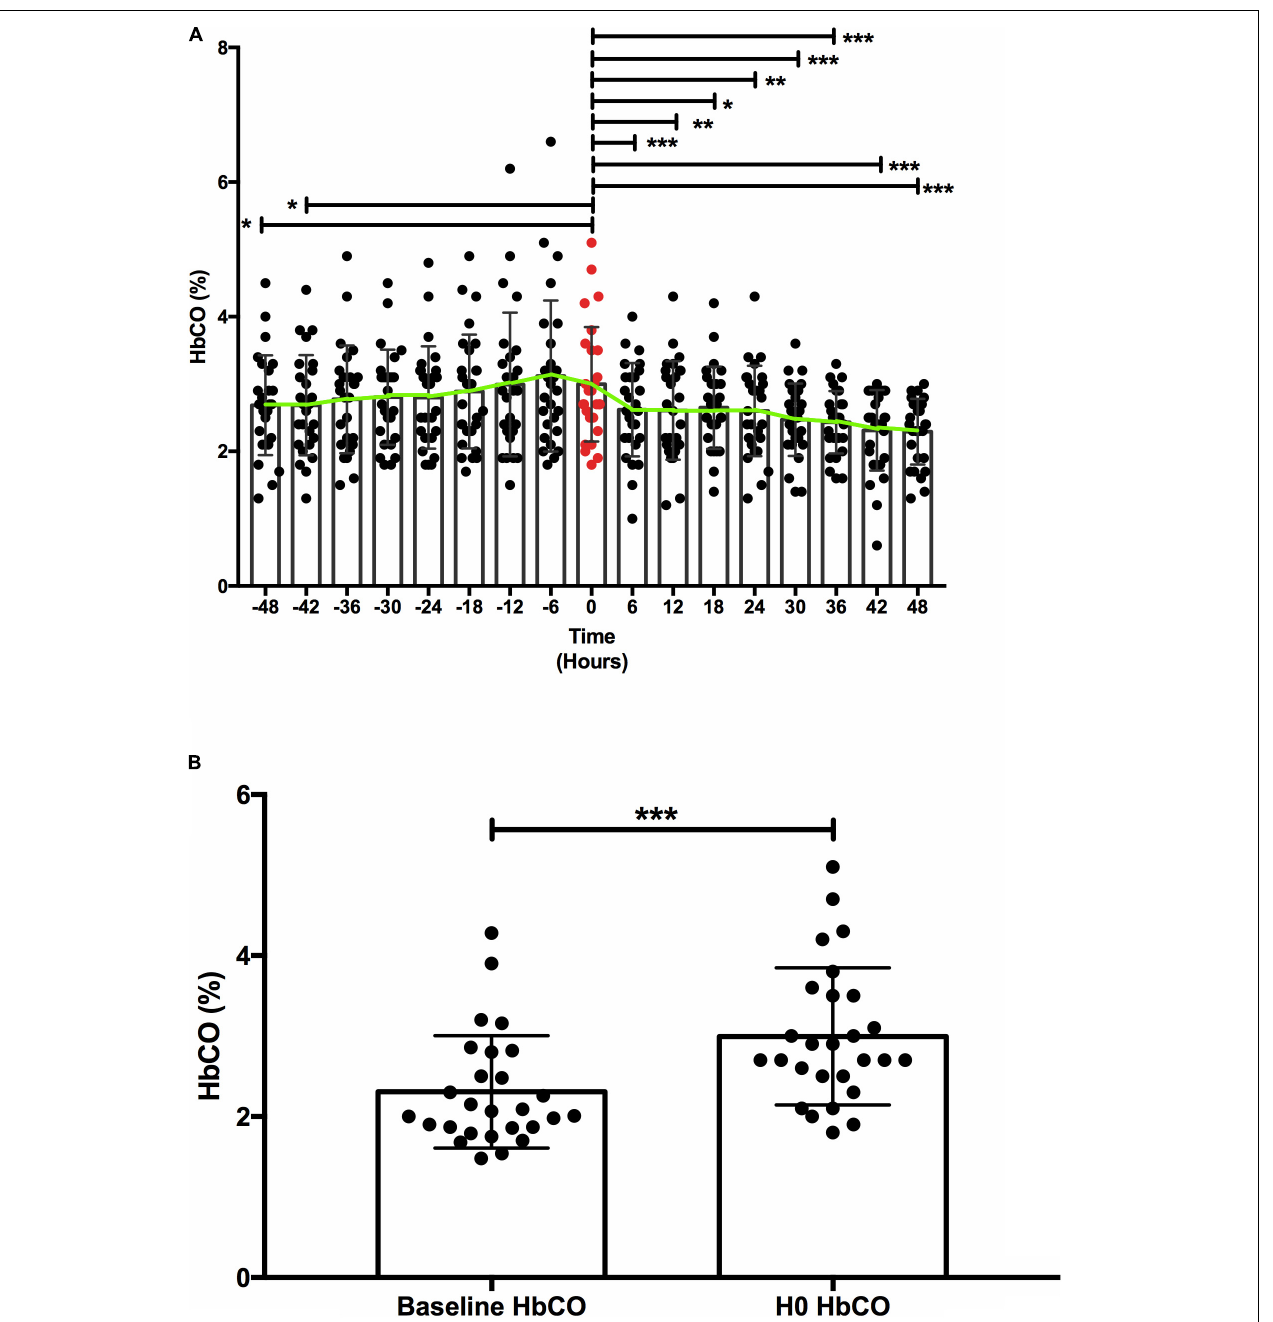
FIGURE 2 | Carboxyhemoglobin (HbCO) evolution. (A) HbCO evolution before/after oxygenator replacement. (B) Carboxyhemoblobin baseline compared to carboxyhemoglobin at oxygenator replacement. (A) Comparison of mean ( ± SD) HbCO before and after oxygenator replacement. Green line connects HbCO mean at each time point. The red value represents the HbCO value at the oxygenator change, at H0. Y axis: HbCO (%), X axis: time in hours. * < 0.05 ** < 0.01 *** < 0.001. (B) H0 HbCO was significantly higher [median 2.7 (IQR 2.5–3.5)] than baseline HbCO [median 2.07 (IQR 1.86–2.8)], with a p value < 0.001. Y axis: HbCO (%), X axis: time-point *** <